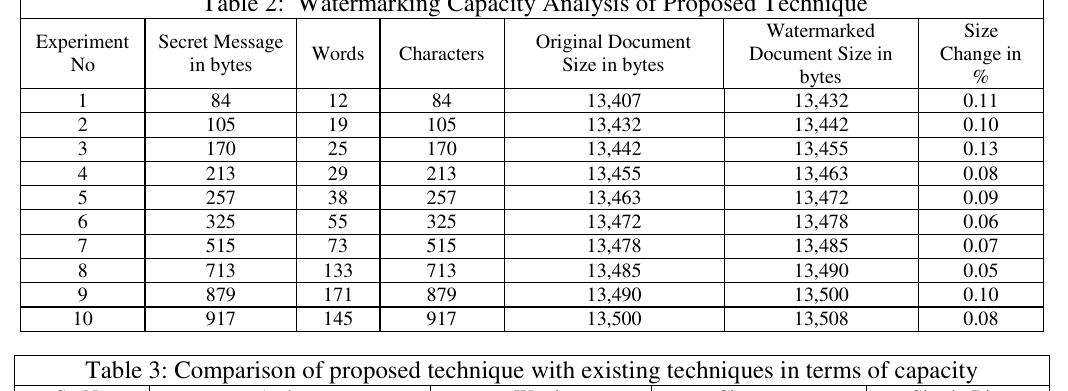
Table 3: Comparison of proposed technique with existing techniques in terms of capacity Sr. No